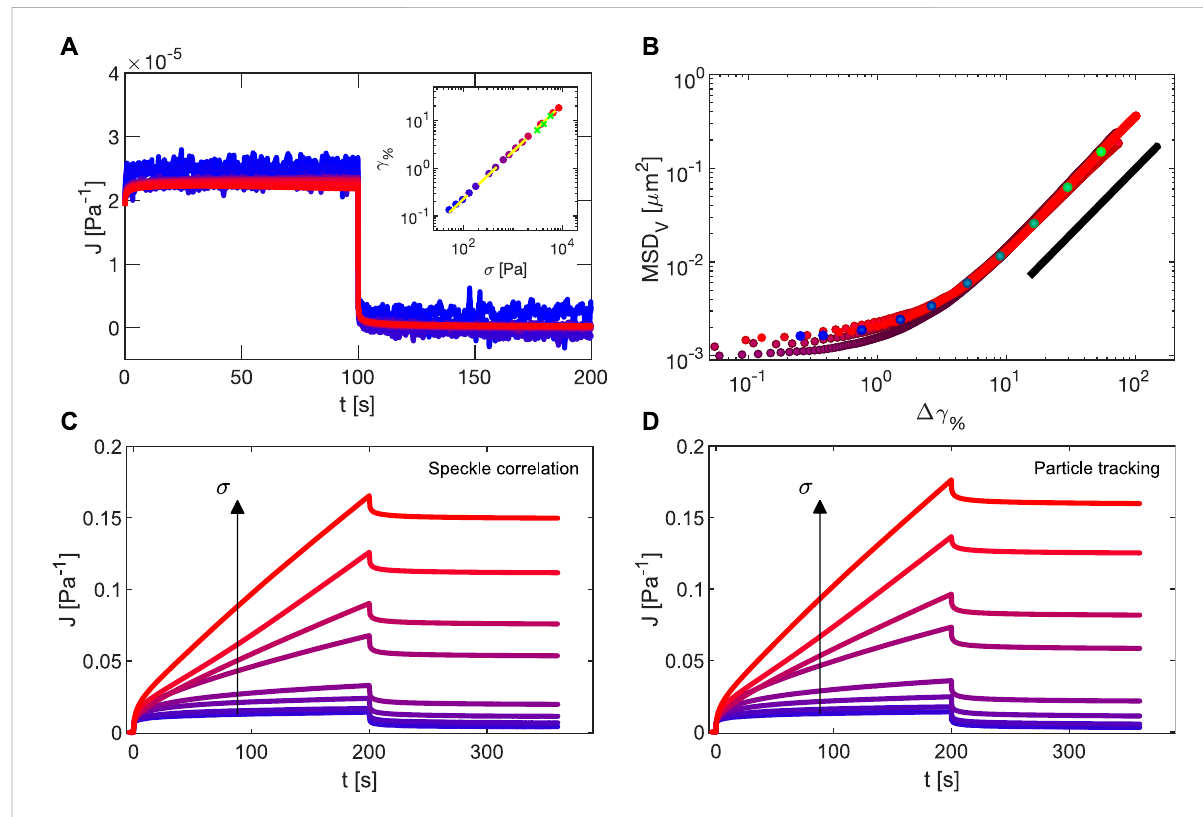
FIGURE 12 (A) CompliancemeasuredinaseriesofcreepandrecoveryexperimentsonaSylgardsamplewithshearmodulus4.5 · 10 4 Pa.Colorscaleranges from the lower (blue) to the highest (red) applied stress, accordingly to the values reported on the abscissa of the inset, where the fi tted strain creep plateau values are reported. In the inset, dashed white line is a linear fi t of the plateau strains. Green points are the results obtained in oscillatory regime on the same sample. (B) MSD in the vorticity direction as a function of the strain, recovered from the four largest applied stresses of the datasetofC,onwhich itispossibleto identifyaconstantstrainrateonthetime interval [ 40 , 150 ] s.The blacklineisaguideto theeye,representing a power law with exponent 1.4 (C) Macroscopic compliance measured from speckle correlation in a series of creep and recovery experiments with Carbopol 5%. Color scale ranges on the applied stresses ranging from σ = 4.7 Pa (blue) to σ = 51.8 Pa (red). (D) Local compliance measured from PT for the same